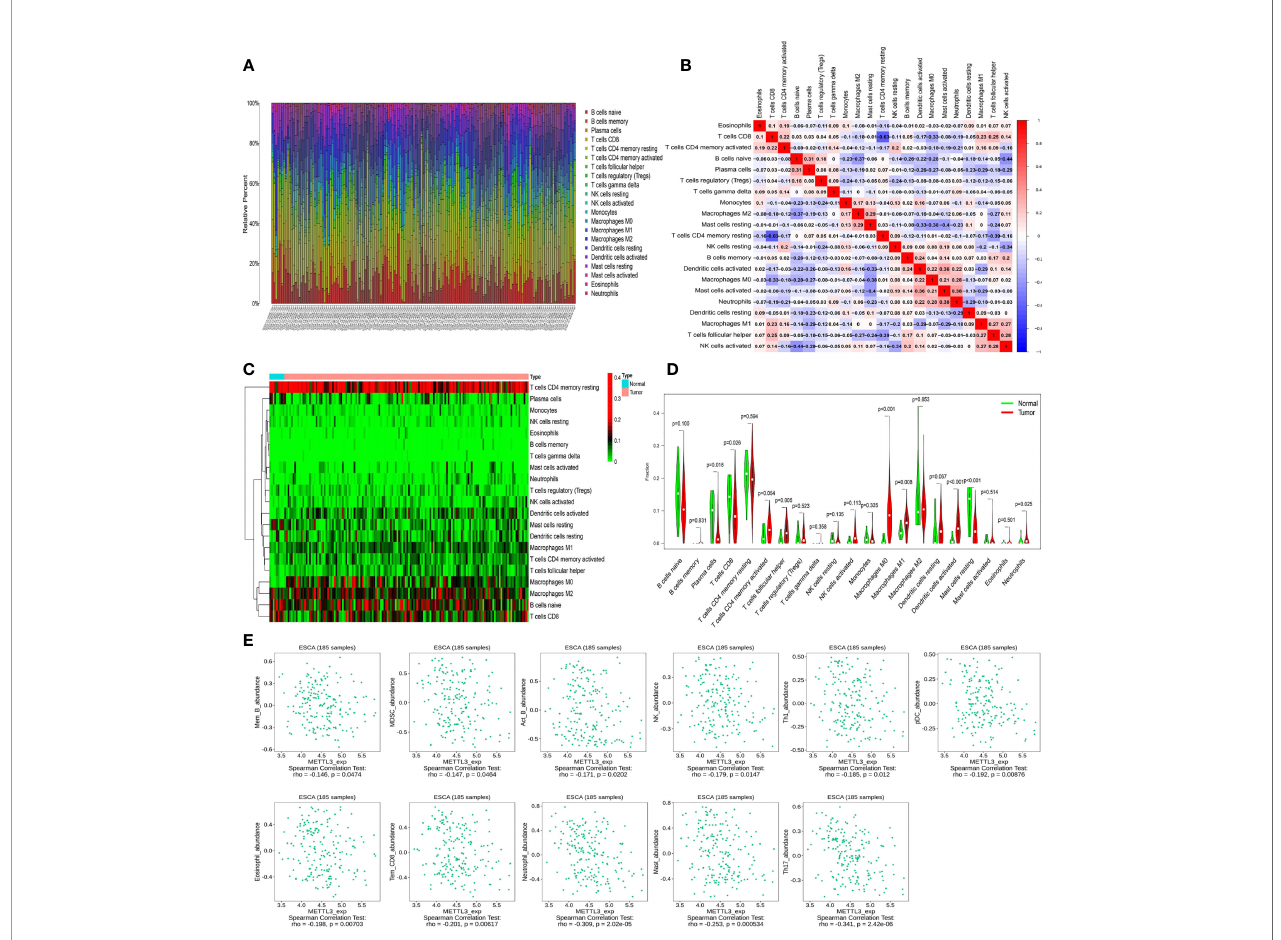
FIGURE 3 | Analysis of immune cell in fi ltration and METTL3 -related immune cells in ESCC. (A) The degree of immune cell in fi ltration in esophageal cancer (different colors represent different immune cells). (B) Correlation analysis between different immune cells (red and blue represent positive and negative correlations, respectively, and correlation coef fi cients are expressed numerically). (C, D) The differential enrichment of immune cells in ESCC and normal tissues. (E) Correlation between METTL3 and immune